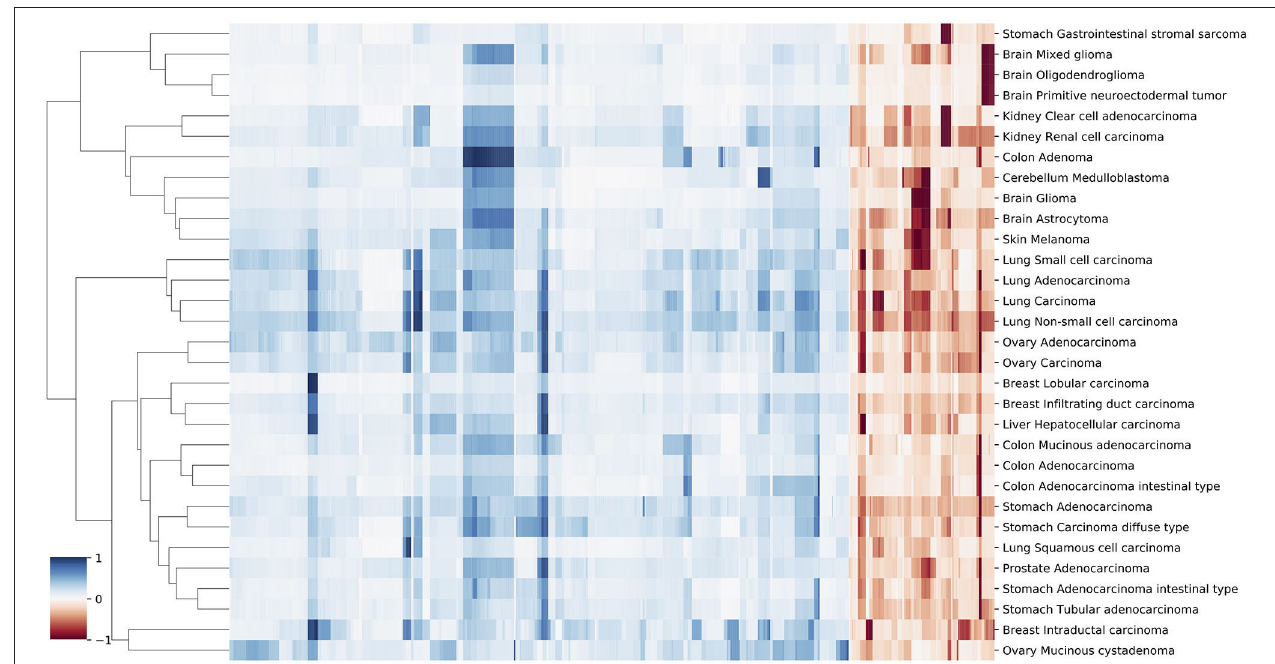
FIGURE 5 | A clustering heatmap of features in 31 signatures. Columns are normalized average CNV intensities of feature genes, where the blue colors are duplication features and red colors are deletion features. Duplication and deletion frequencies are normalized separately.